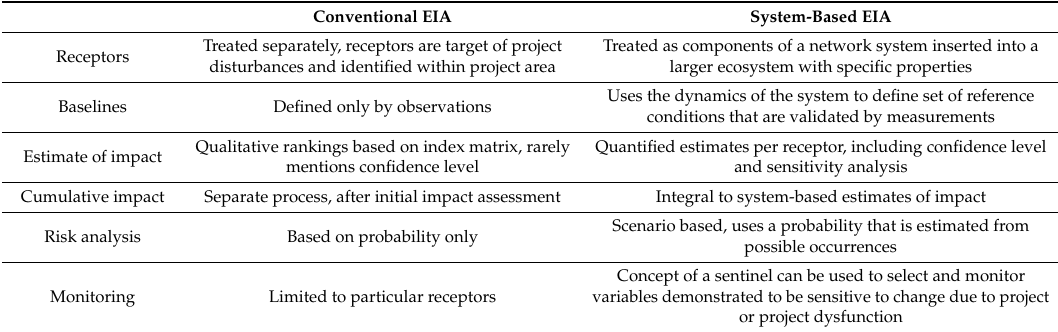
Table 1. Comparing Conventional and System-Based Environmental Impact Assessment (SBEIA).